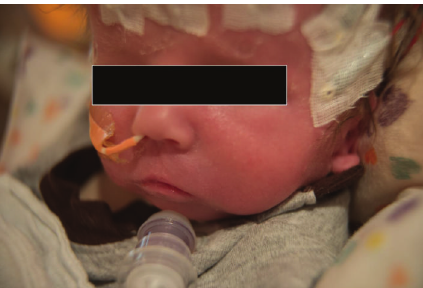
Figure 2: Endoscopy mask (VBM Medizintechnik,